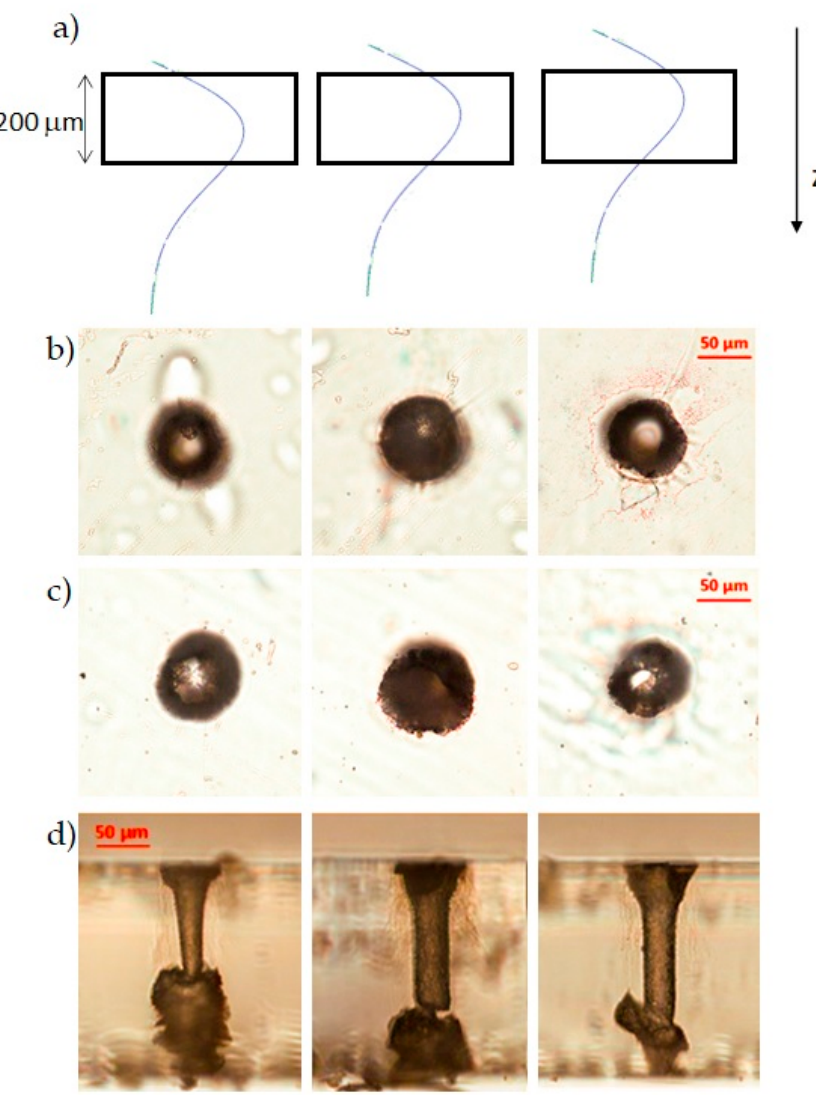
Figure 7. Optical microscope objective images of water assisted micromachining results in AF32 glass. ( a ) Schematic of the relative position between the BB (arbitrarily normalized) intensity profile along z and the sample thickness, in three different micro-drilling configurations; ( b ) top, ( c ) bottom, and ( d ) lateral views of the sample in the three configurations. In each column, the images correspond to a different sample position with respect to the Bessel zone of the beam. From right to left, the sample has been progressively shifted upwards towards the beginning of the Bessel beam intensity profile.